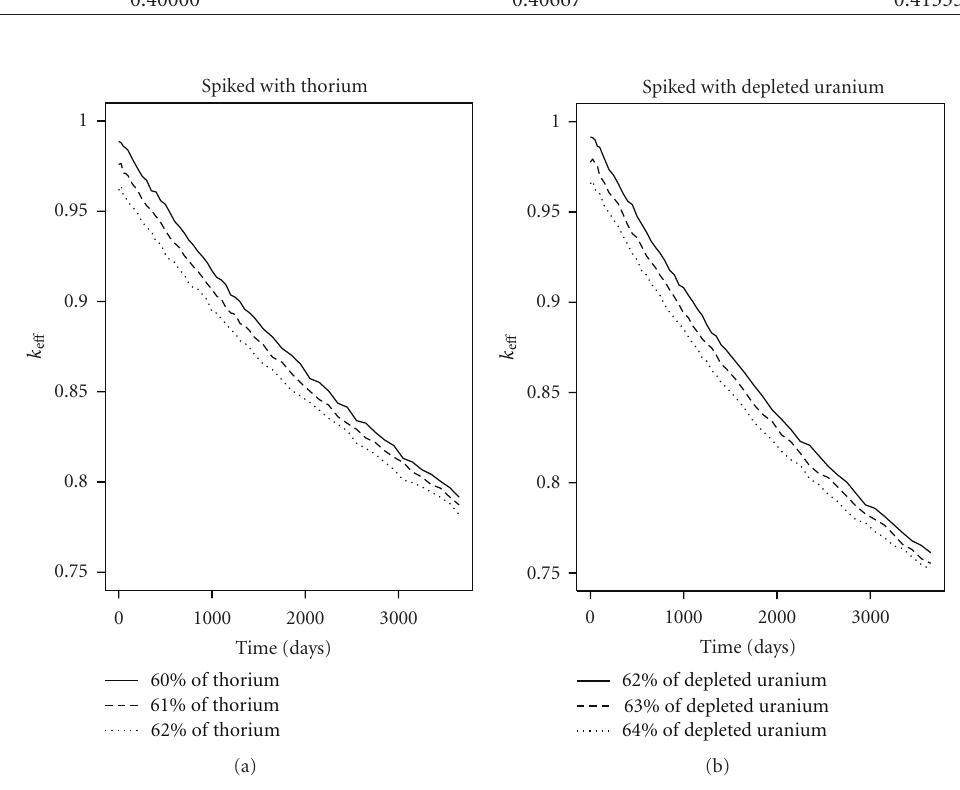
Figure 4: Multiplication factor ( k e ff )